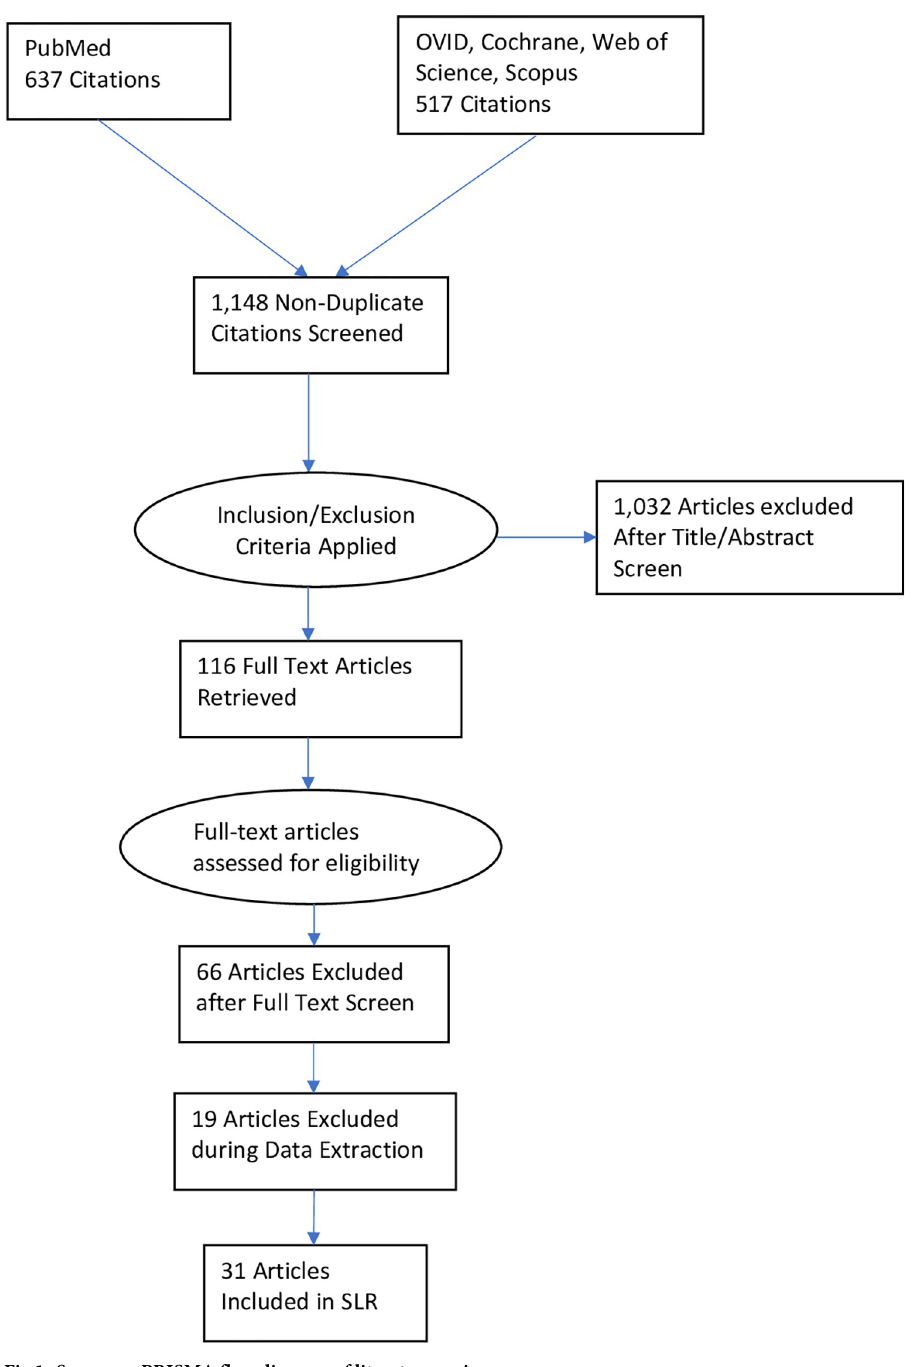
Fig 1. Summary PRISMA flow diagram of literature